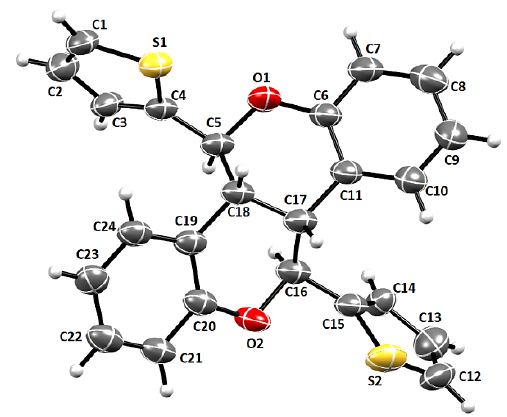
Figure 4. Molecular structure of dimeric photoproduct 2 . Displacement ellipsoids are drawn for the probability of 25% and hydrogen atoms are shown as spheres of arbitrary radii.